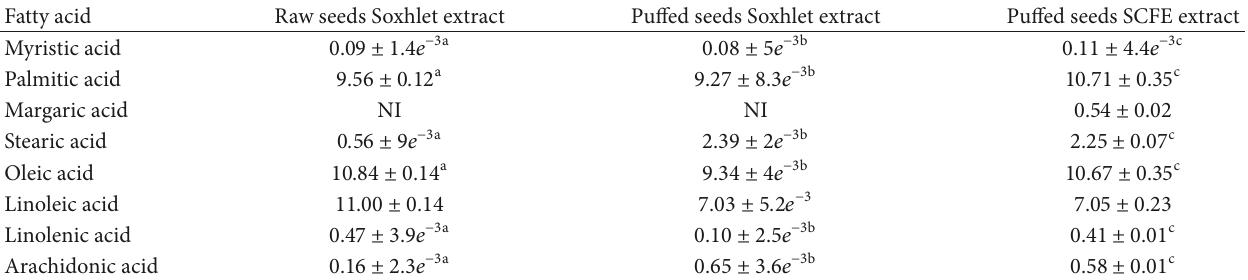
Table 3: Fatty acids content (mg/ml) from A. hypochondriacus extracts determined by